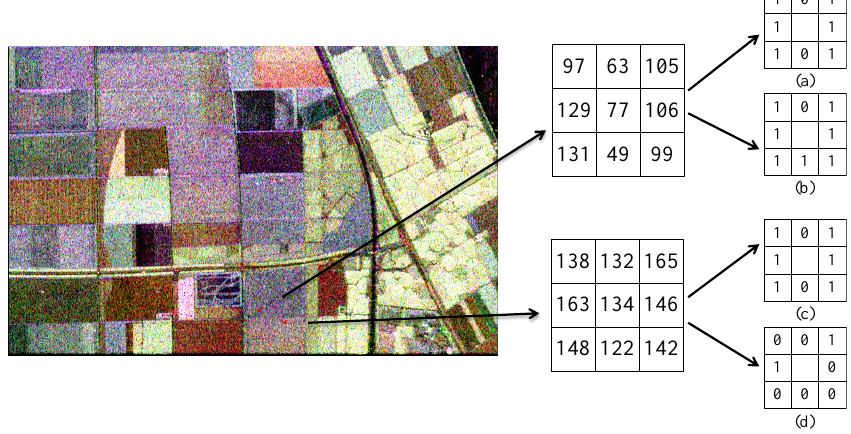
Figure 3. Two pixels belonging to different classes and their binarization results. (a,c) The results by RIU-LBP; (b,d) the results by RHLBP with T = 20 .